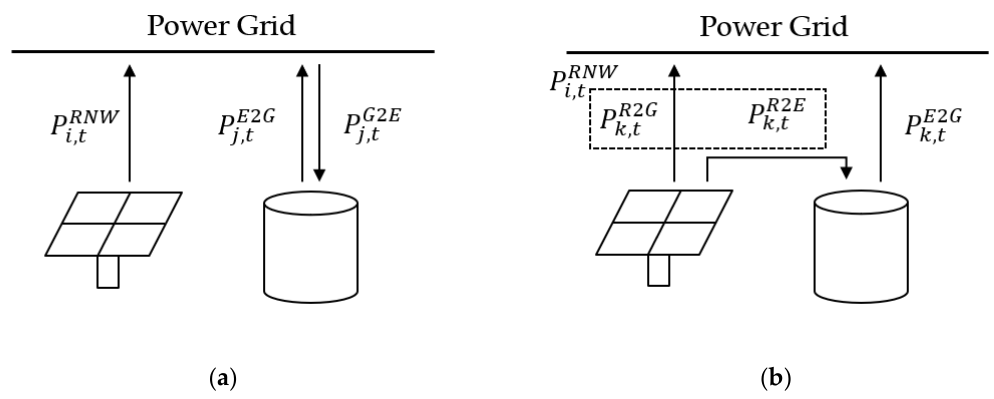
Figure 3. Modeling of RESs and ESSs: ( a ) independent RES and ESS; ( b ) combined RES and ESS.